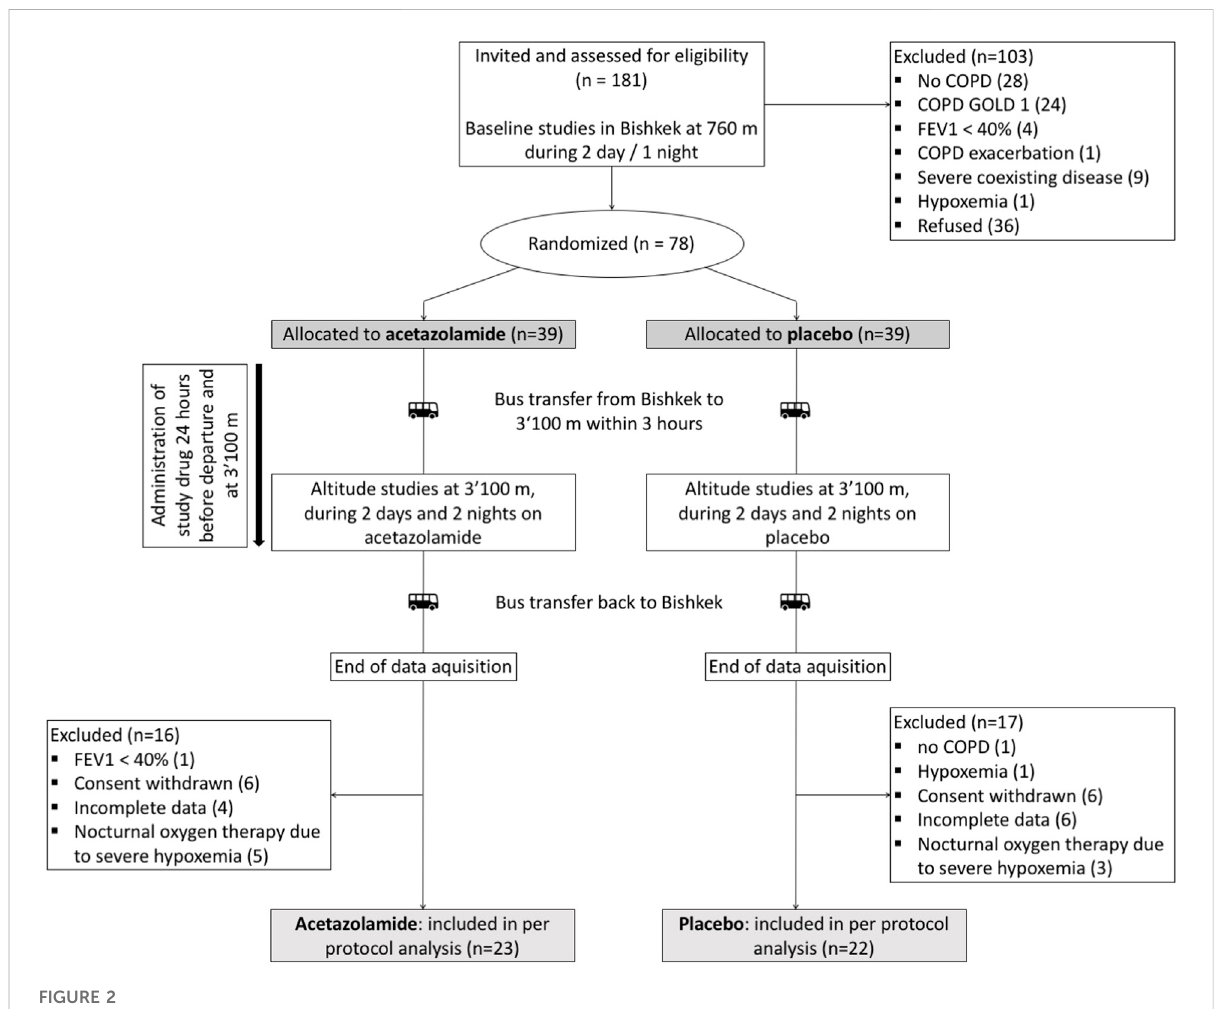
FIGURE 2 Patient fl